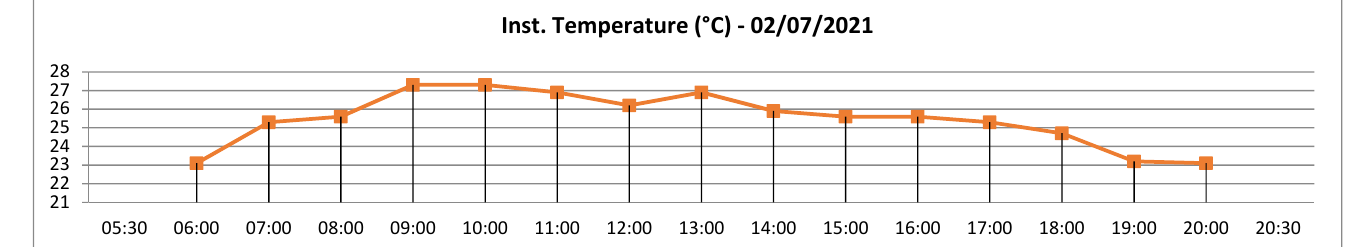
Figure 13. Rio de Janeiro—instantaneous temperature of the weather station. On 7 February and 21 February, the post-instability synoptic conditions (marked by the weakening of the SACZ) were responsible for a heat island that varied from weak (0.1 °C to 2 °C) to moderate intensity (2.1 °C to 4 °C) (Figure 14), lower magnitudes when compared to previous patterns of atmospheric stability and instability.